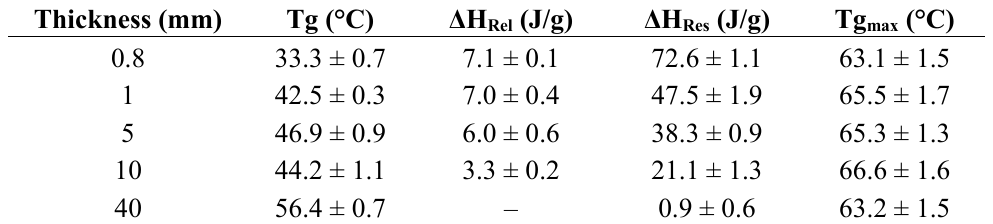
Table 2. Tgmidpoint, ΔH res , ΔH rel and Tg max values measured by dynamic DSC scans for 7-day cold-cured samples, as function of the thickness of the